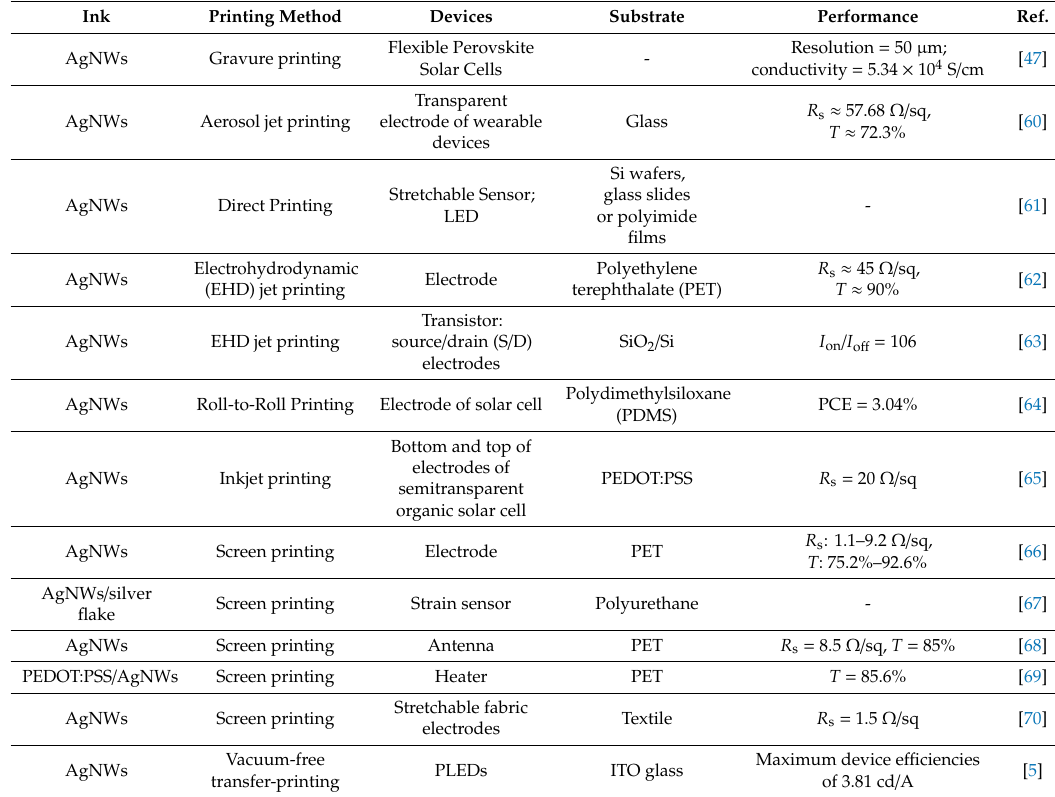
Table 2. The applications of Ag NW